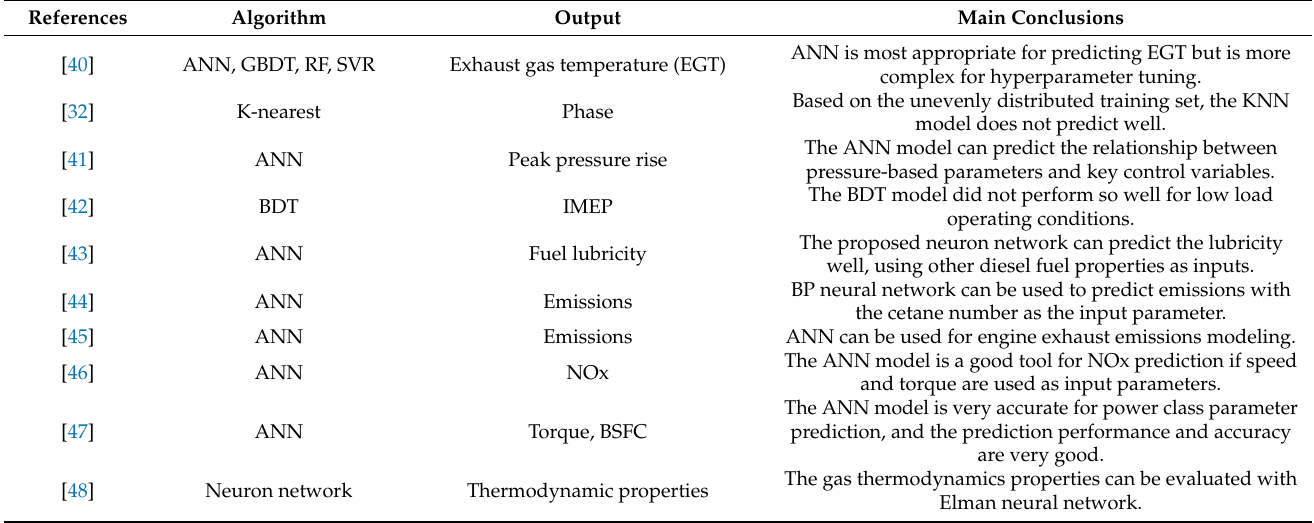
Table 1. Various algorithms for engine responses